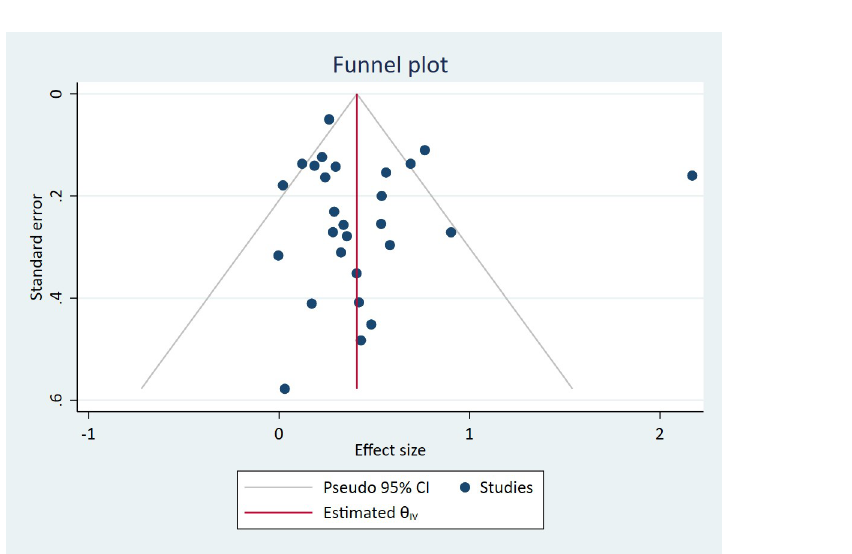
Fig 5. Funnel plot for simple working memory